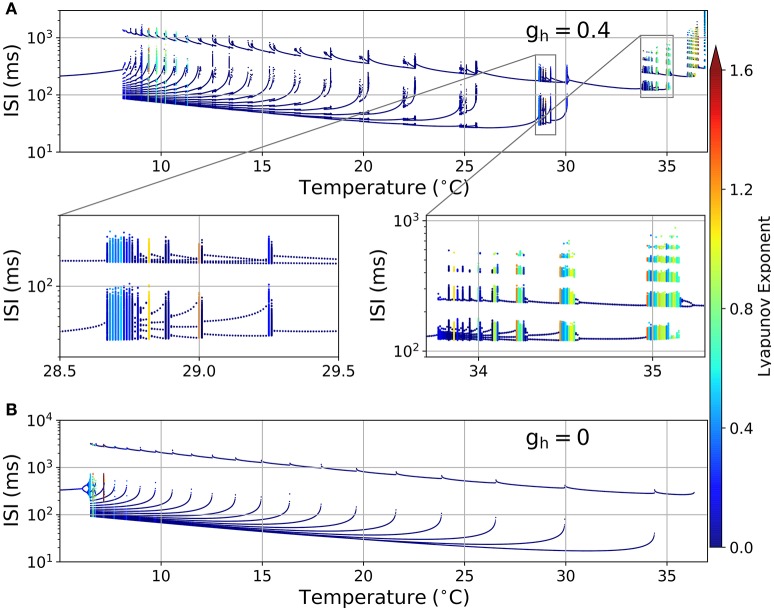
(A) ISI bifurcation plot of the HB+Ih model as temperature is changed. Each temperature was independently simulated (from 0 to 40 °C in 0.01 °C intervals), and the spikes were considered to occur each time the voltage crossed a −15 mV threshold. The color of the dots represents the Lyapunov exponent calculated from the ISI series. Two sections are shown below in expanded horizontal scale. (B) ISI bifurcation plot of the model in the absence of Ih (gh = 0).